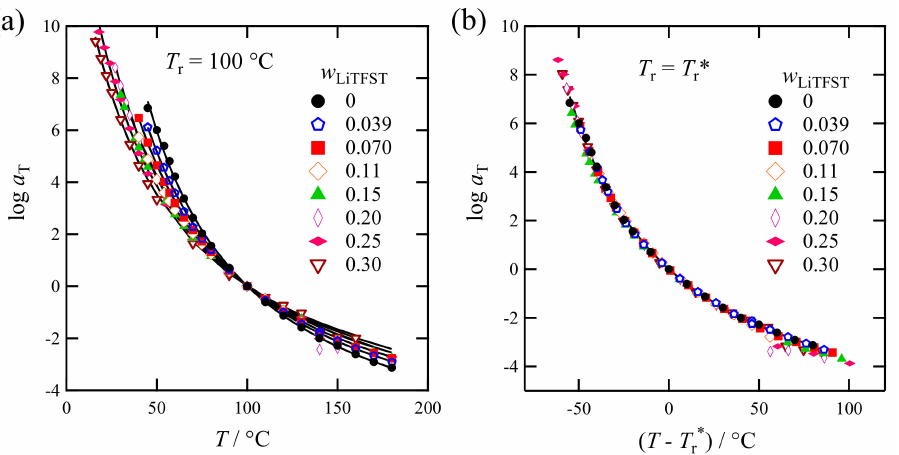
Figure 9. ( a ) Temperature dependence of the viscoelastic shift factors a T for the PC 4 -TFSI/LiTFSI mixtures at T r = 100 ◦ C. The solid curves represent the WLF functions. ( b ) T − T r * dependence of the shift factors a T at each reference temperature set to be T r * shown in Table